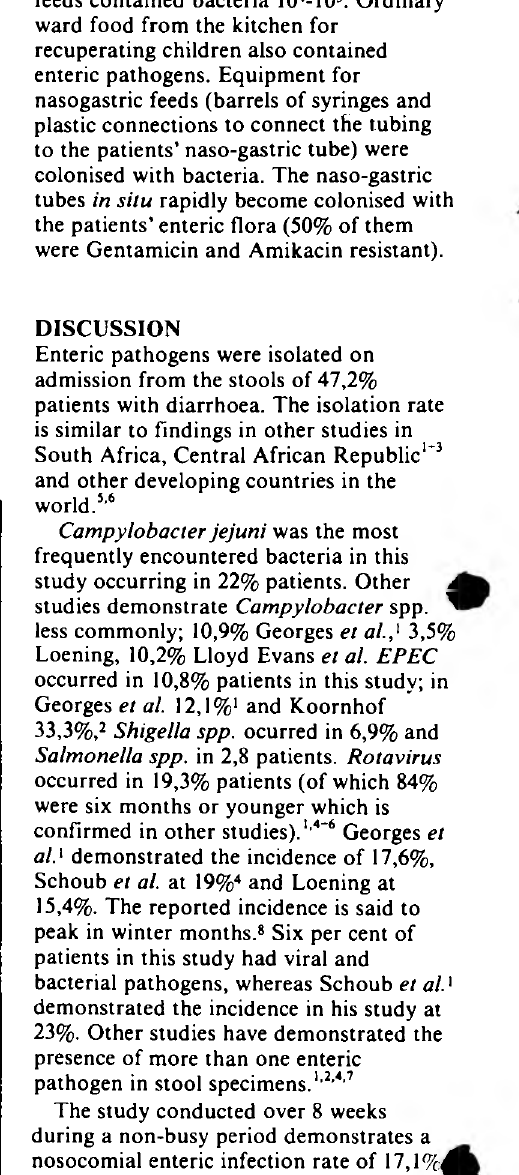
TABLE 5 Feeds and Feed